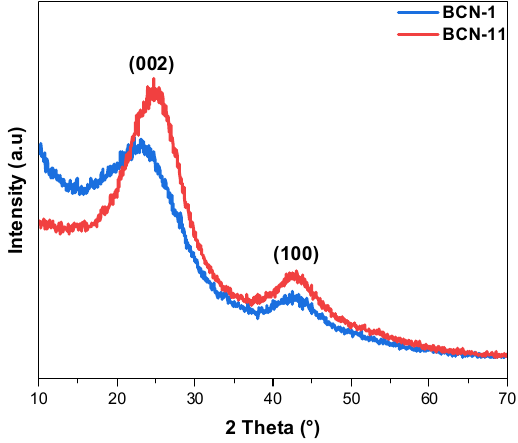
Figure 4. XRD patterns of BCN-1 and BCN-11.